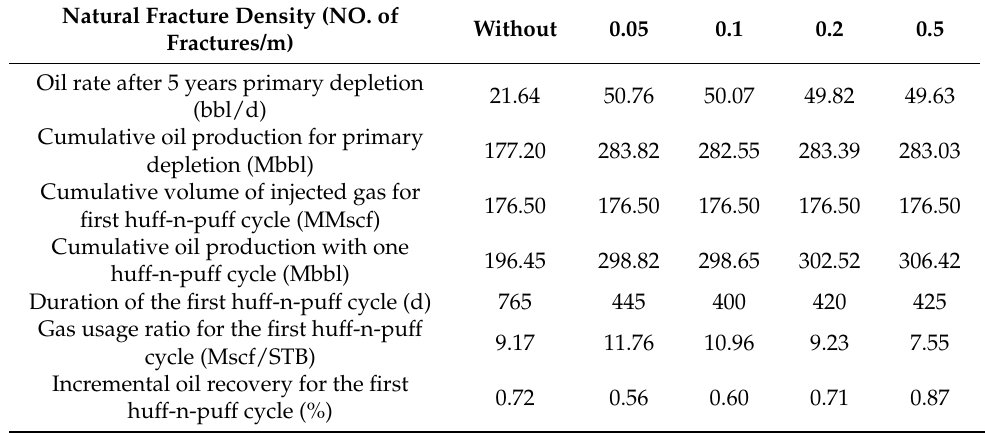
Table 11. Summary of results for huff-n-puff with different natural fracture